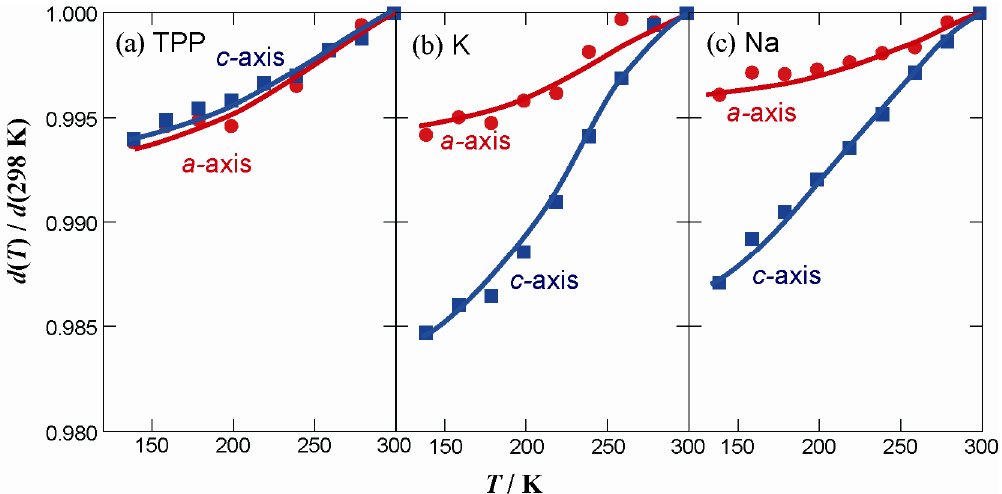
.4(EtOH). The red broken line ] 2 2 ]...K(EtOH) ...[Co(Pc)(CN) ] 2 4 2